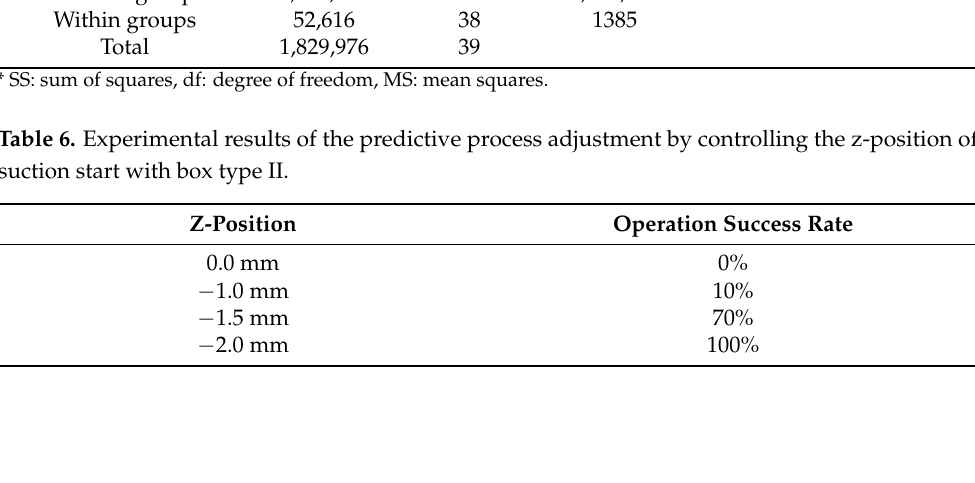
Table 5. ANOVA results of the effect of the z-position on the pick-up operation of the gripper. Source